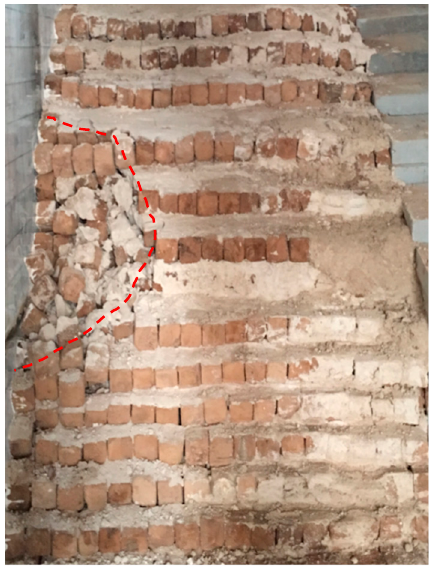
Figure 13. Front view of the model slope after four stages of mining. Subsidence pit was formed above the mining